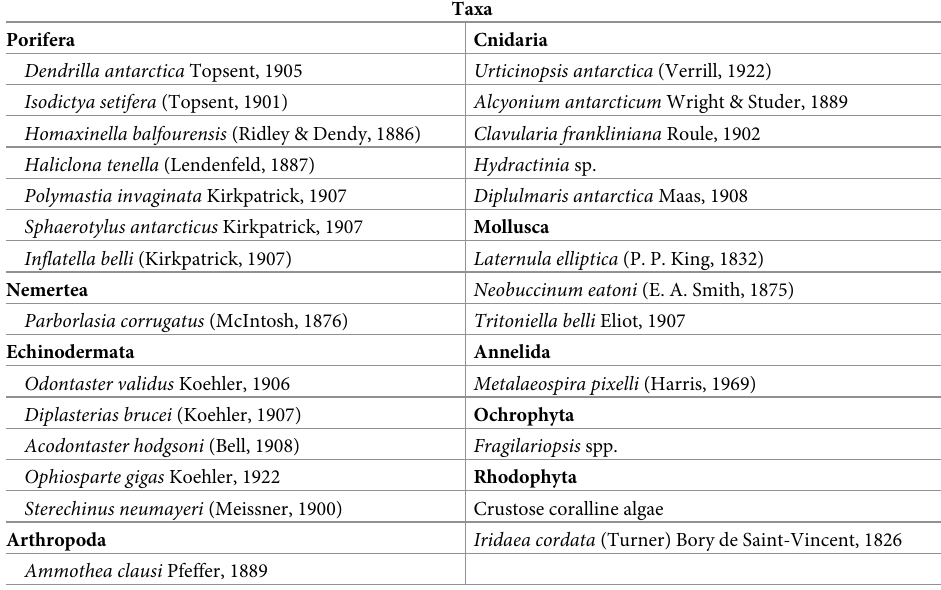
Table 1. List of species observed at the study area in Terra Nova Bay during the experimental period, 2012–2018, via video